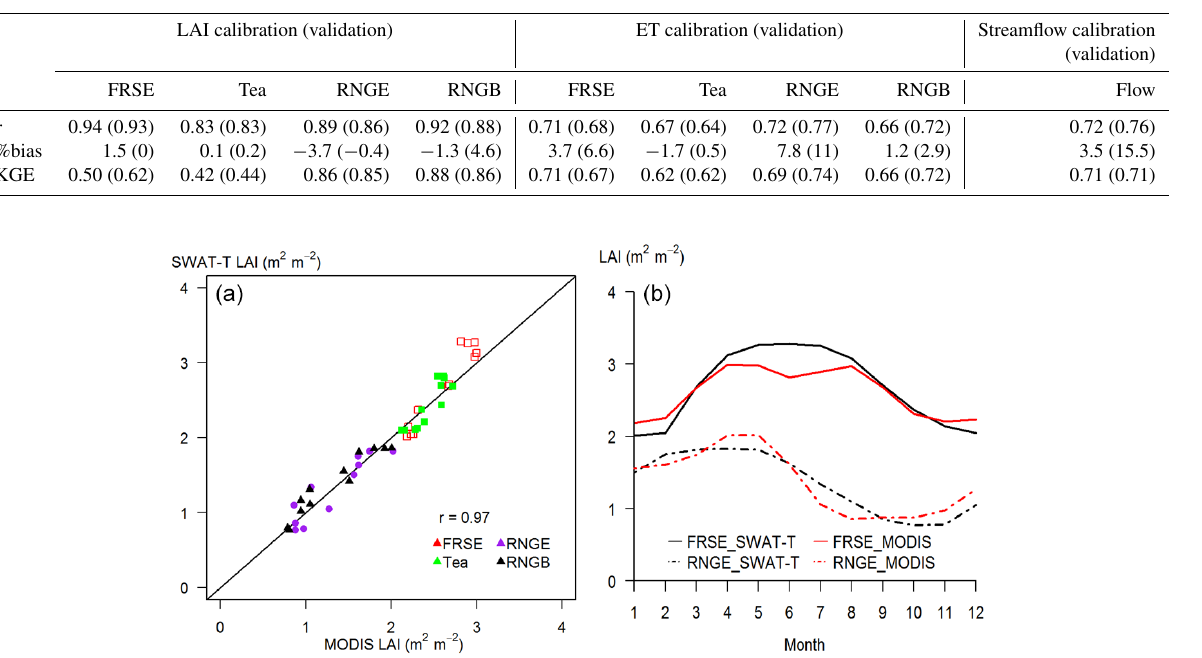
Figure 8. The long-term (2002–2009) average monthly LAI pooled scatter plot (a) and temporal dynamics (b) . FRSE: evergreen forest; RNGE: grassland; RNGB: